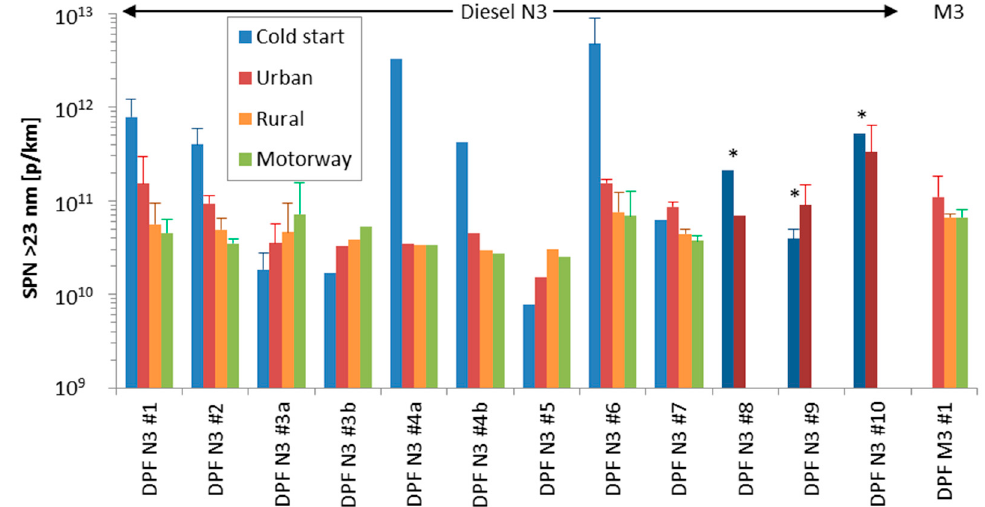
Figure 3. Urban cold start, urban hot, rural and motorway SPN emissions. Upper panel for CNG, LNG and diesel N2 vehicles. Lower panel for diesel N3 and M3 vehicles. Asterisk * indicates that the two columns refer to the complete WHVC (cold or hot). Error bars show the maximum value when 2 or more repetitions were available. The small letters “a” and “b” indicate testing of the same vehicle after approximately 3–6 months.